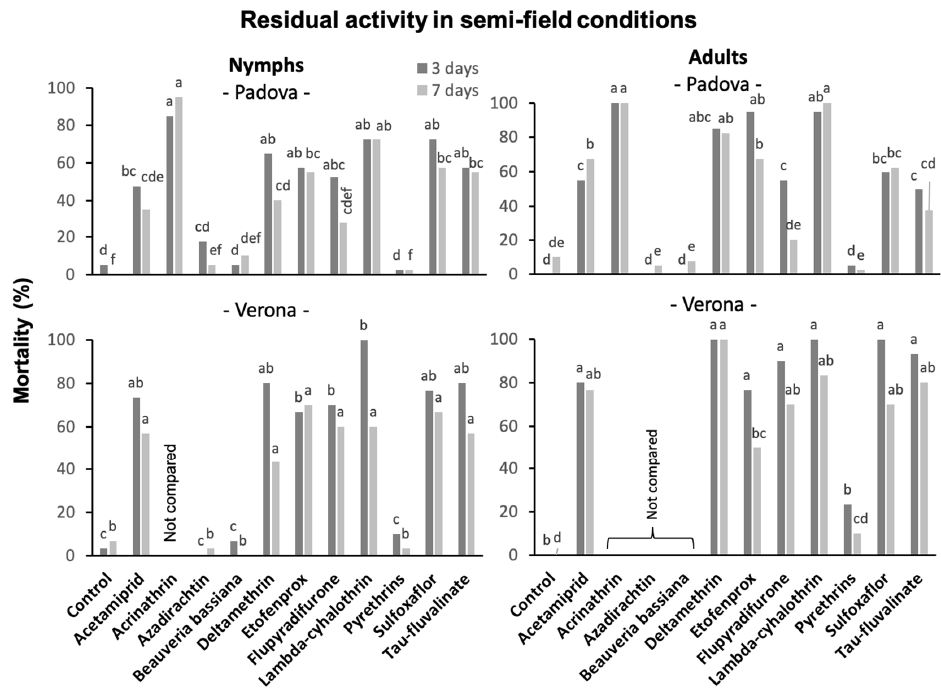
Figure 5. Mortality rates of S. titanus nymphs and adults confined on leaves three and seven days after insecticide application in semi ‐ field conditions in Padova and Verona Universities. Different letters above the columns with the same color indicate significant differences at the t ‐ test ( α = 0.05). In the trial carried out at the University of Verona, S. titanus nymphs were signifi ‐ cantly affected by insecticides when confined on plants three and seven days after their